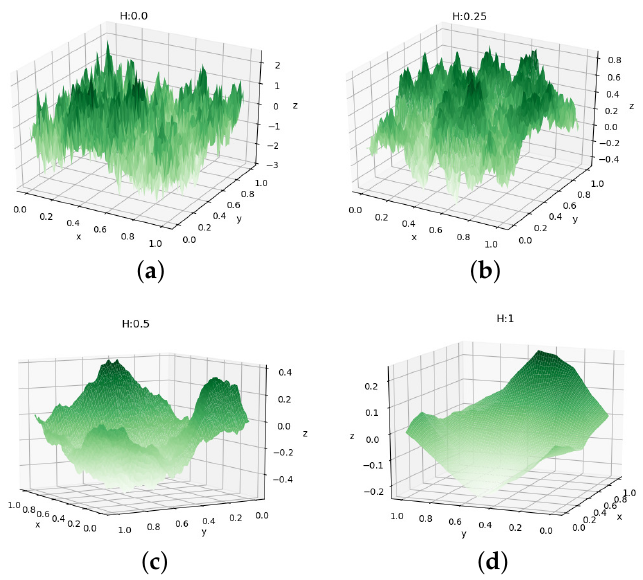
Figure 11. Surface landscapes generated by 2DMD for ( a ) H = 0.0, ( b ) H = 0.25, ( c ) H = 0.50, and ( d ) H =